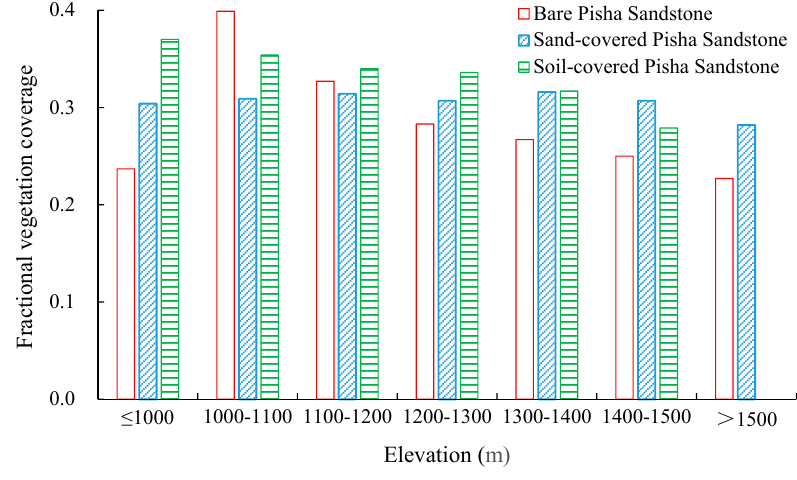
Figure 8. Variations in fractional vegetation coverage and elevation in different Pisha Sandstone types.